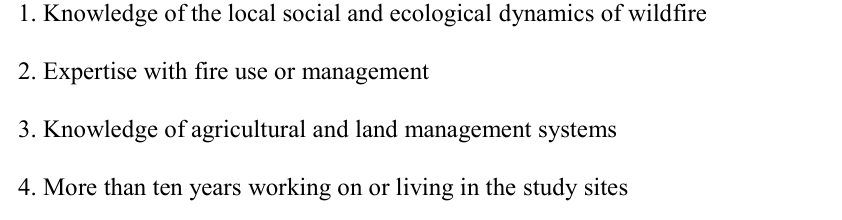
Table A1.2. Criteria to select expert participants for the focus